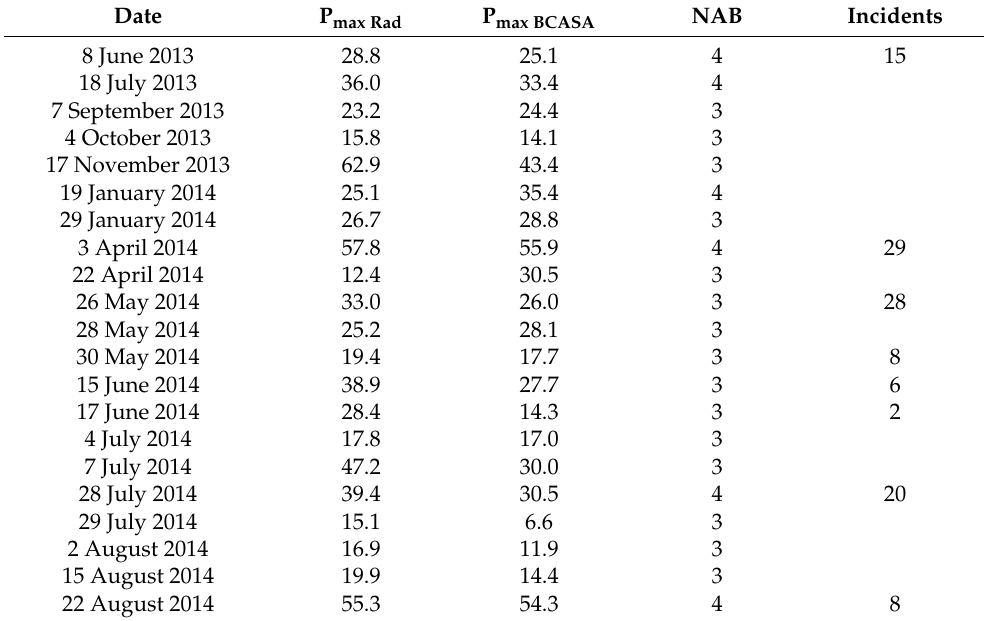
Table A2. Rainfall episodes in Barcelona with NAB levels greater than or equal to 3. Maximum cumulative values of precipitation from radar data and rain gauges data are also provided along with the NAB level achieved and the number of incidents reported to Barcelona City